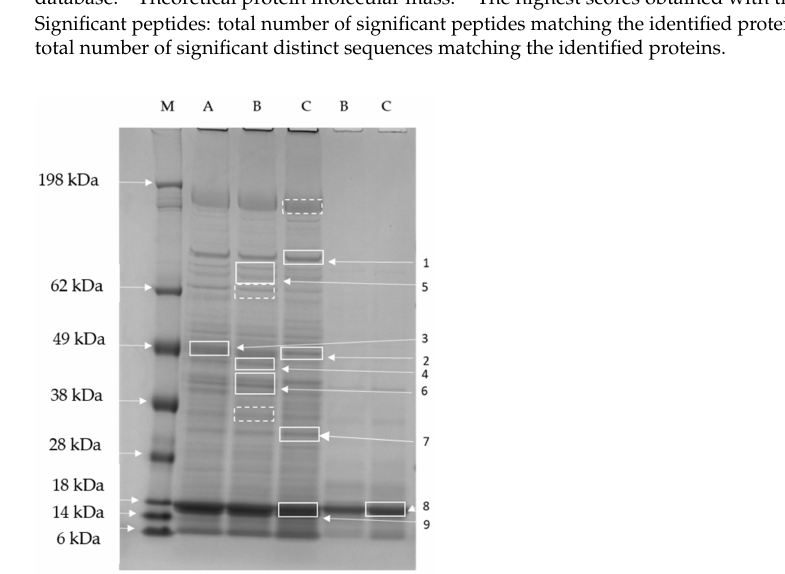
database. c Theoretical protein molecular mass. d The highest scores obtained with the Mascot search engine. e